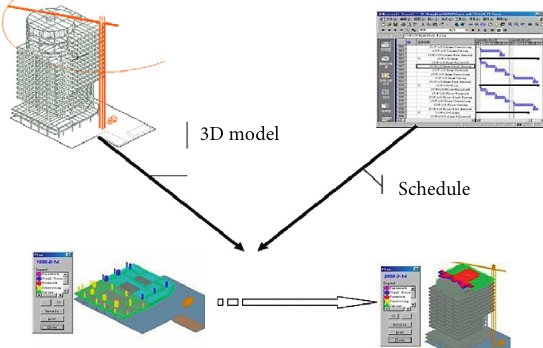
Figure 2: 4D concepts [14,